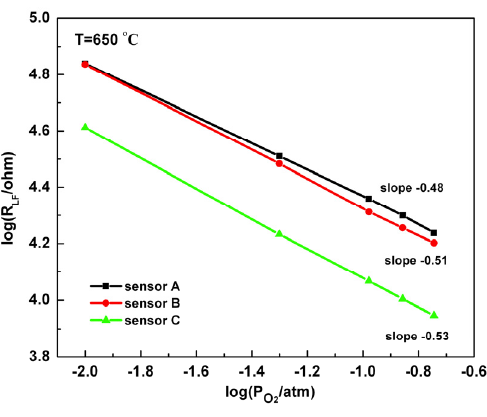
Figure 5. O concentration dependence of R 2 have 50, 48, and 46% porosity, respectively.